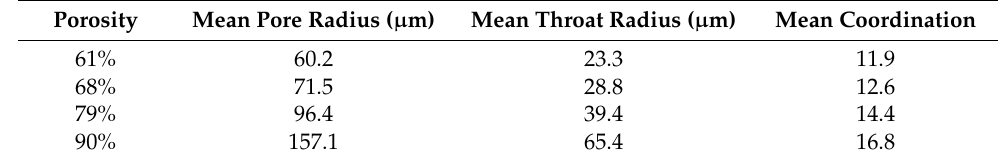
Figure 5. Distributions of pore radius, throat radius, and coordination number in 61%, 68%, 79%, and 90% porosity PMFSS. Table 1. Effect of porosity on the mean values of pore and throat radius and coordination number.